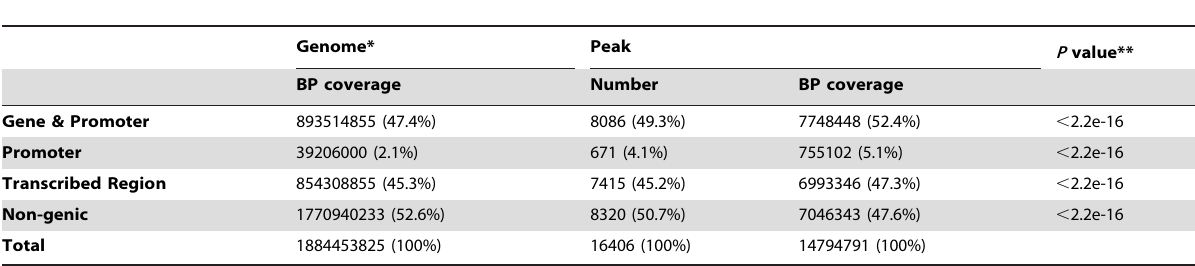
Table 1. Bmi1-dependent peak distribution throughout the mouse